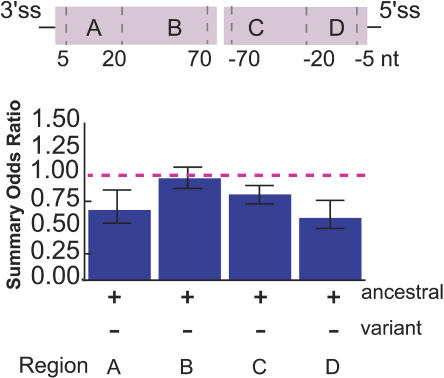
Selection against Disruption of Predicted ESEs in Different Exon RegionsSummary ORs were calculated for mutations that disrupt RESCUE-ESEs as in Figure 2, for each of four regions spanning the length of a typical human internal exon. The heights of the blue bars represent the odds that an ESE will be disrupted by a mutation in the set of 2,561 validated SNPs (selected mutations) relative to the odds of disruption in the set of 100,000 simulated (unselected) mutations. Error bars extend one standard deviation on either side of the calculated value.